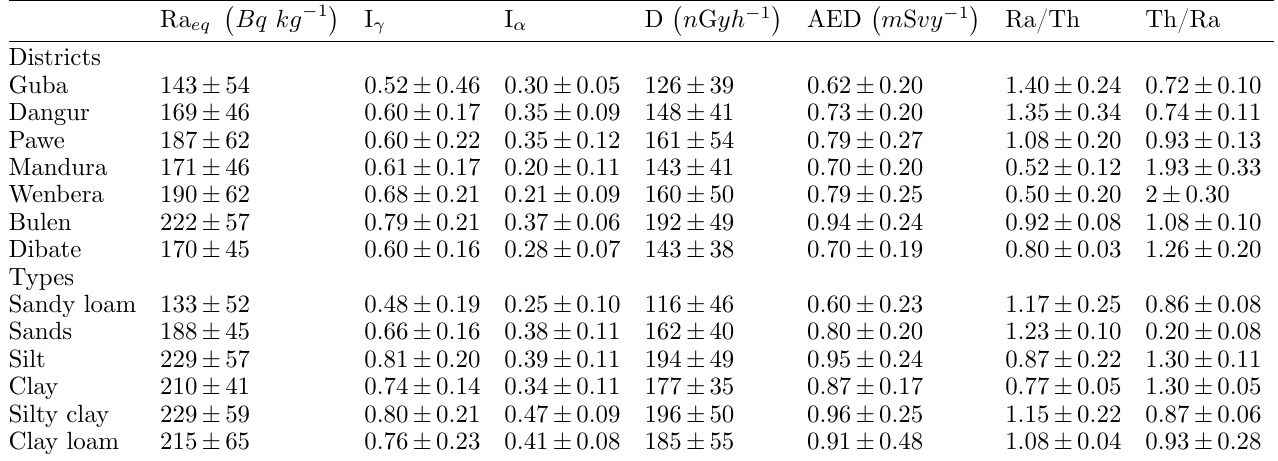
Table 3. The calculated results for radiological health indices parameters in the different districts in Metekel and the soil